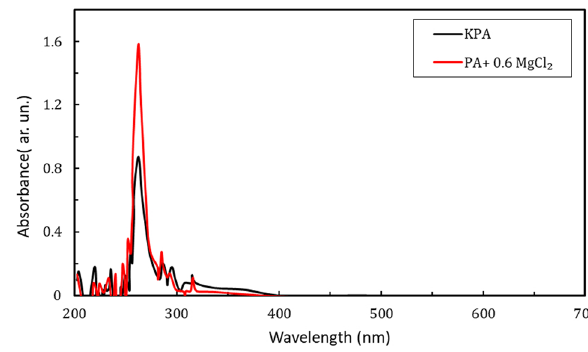
Figure 7: UV - Vis spectra of KPA and Mg - PA ( 0.6 g MgCl 2 )